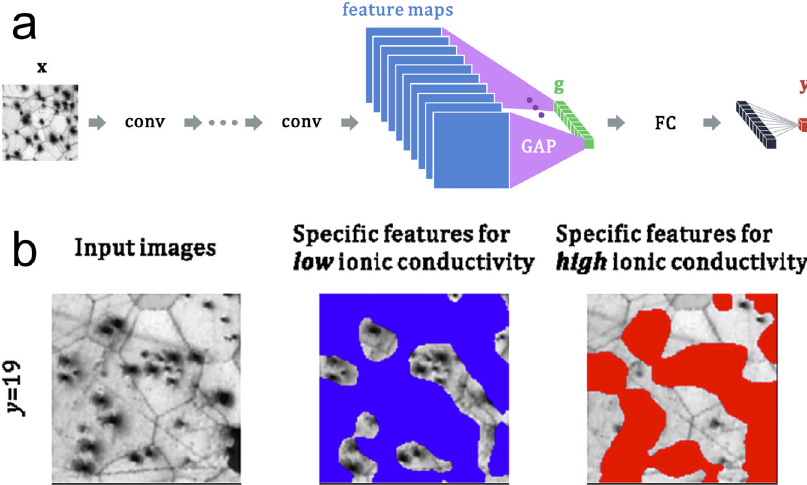
Fig. 3 Example heat map explanations for a CNN with image inputs. The task is to predict the ionic conductivity of a ceramic material from its image quality maps. a CNN model architecture. The last convolution layer is connected with the fi rst fully connected layer via global average pooling (GAP), which allows the tracking of implicit attentive response weights from the top fully connected layers to pixel locations on the original image. b Heat map masked input images. The blue and red regions hide image features that were ignored by the CNN when predicting low and high ionic conductivities. Figure reprinted from ref. 21 with permission. Copyright 2017